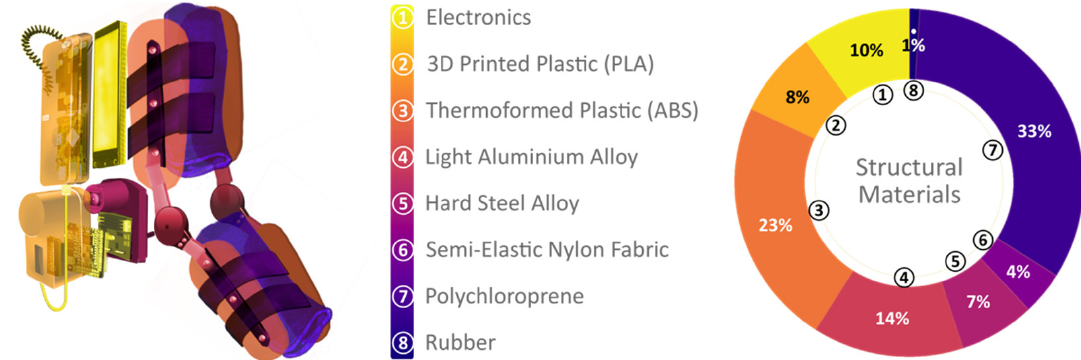
Figure 4. Materials used in the prototype and their percentage, proportional to the total volume.